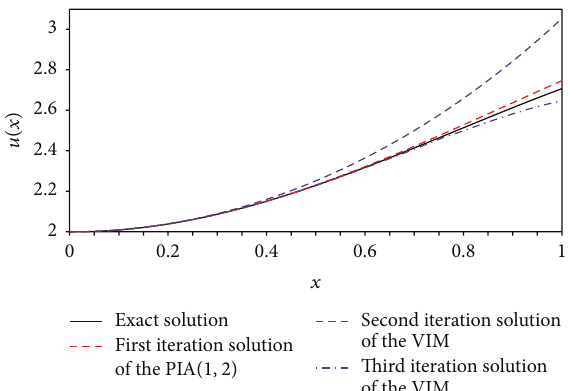
Figure3:ThecomparisonofthethirditerationsolutionsoftheVIM and PIA (1,1) with exact solution for example 4.